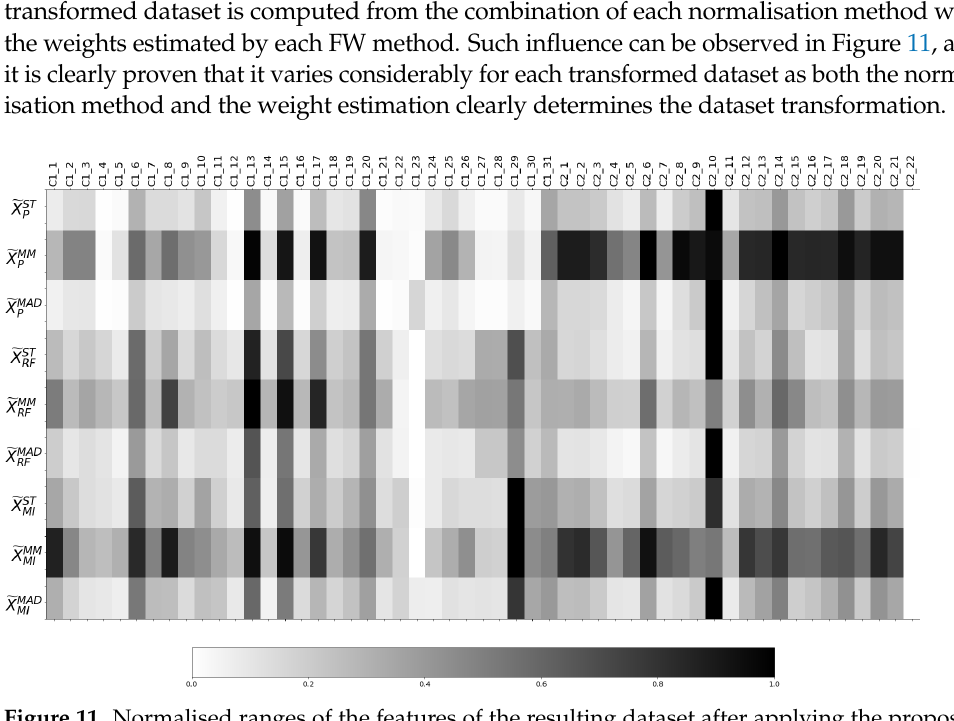
Figure 11. Normalised ranges of the features of the resulting dataset after applying the proposed two-stage